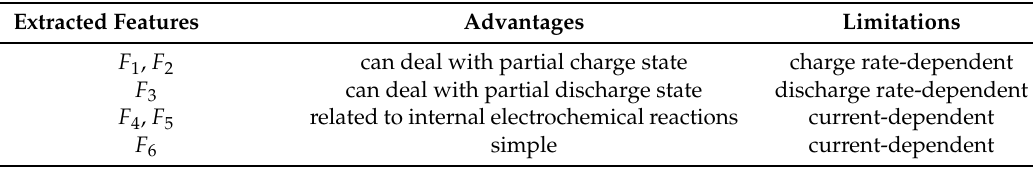
Table 2. The pros and cons of the extracted